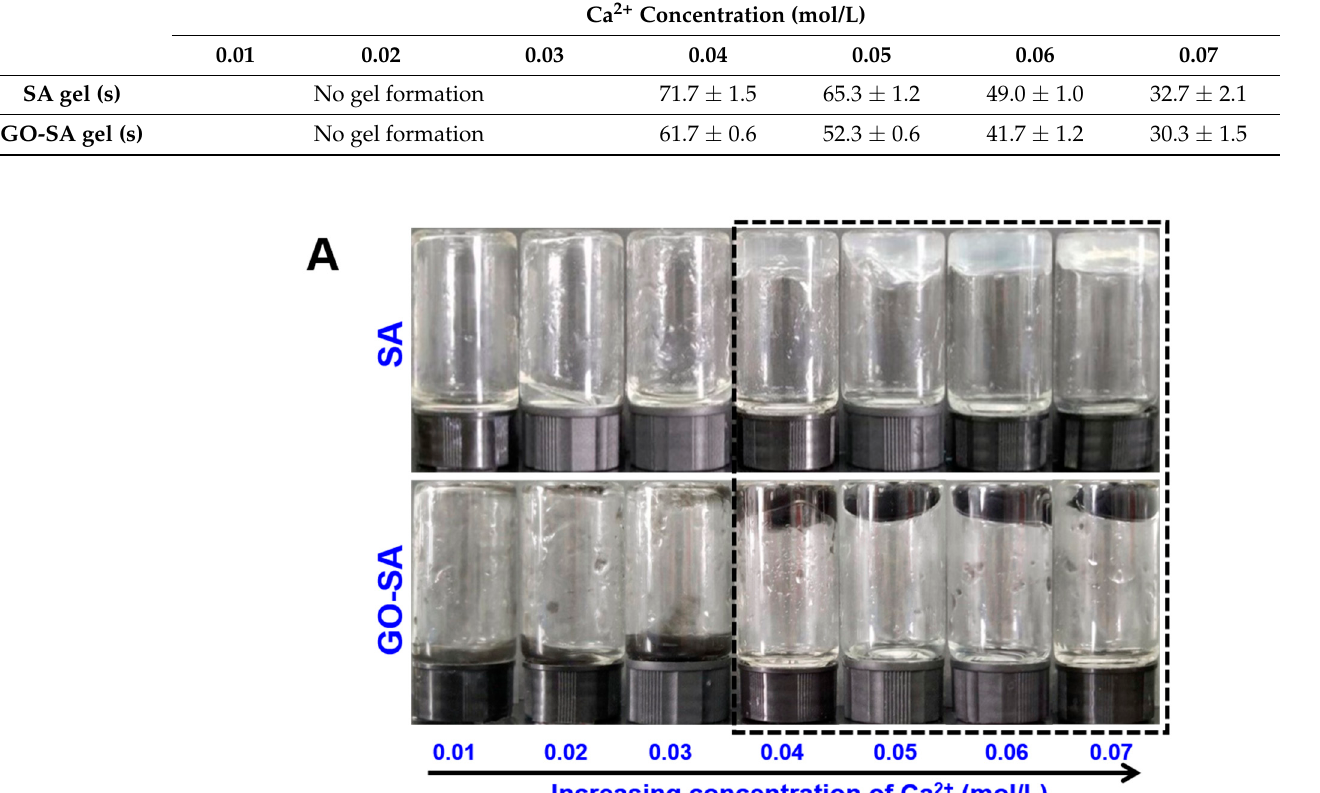
Table 1. Gelation time of GO-free and GO-integrated SA hydrogels. Gelation time recorded in seconds. Ca 2+ Concentration (mol/L)